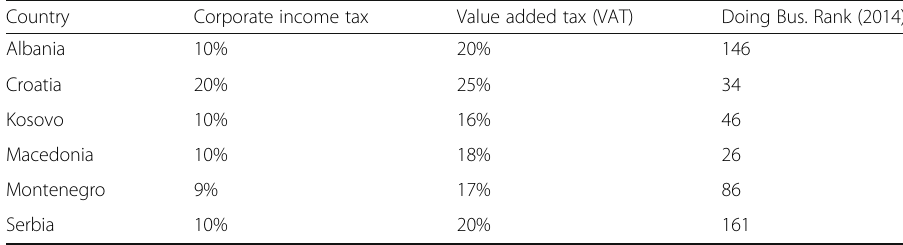
Table 7 Tax rates in Kosovo and comparator countries Country